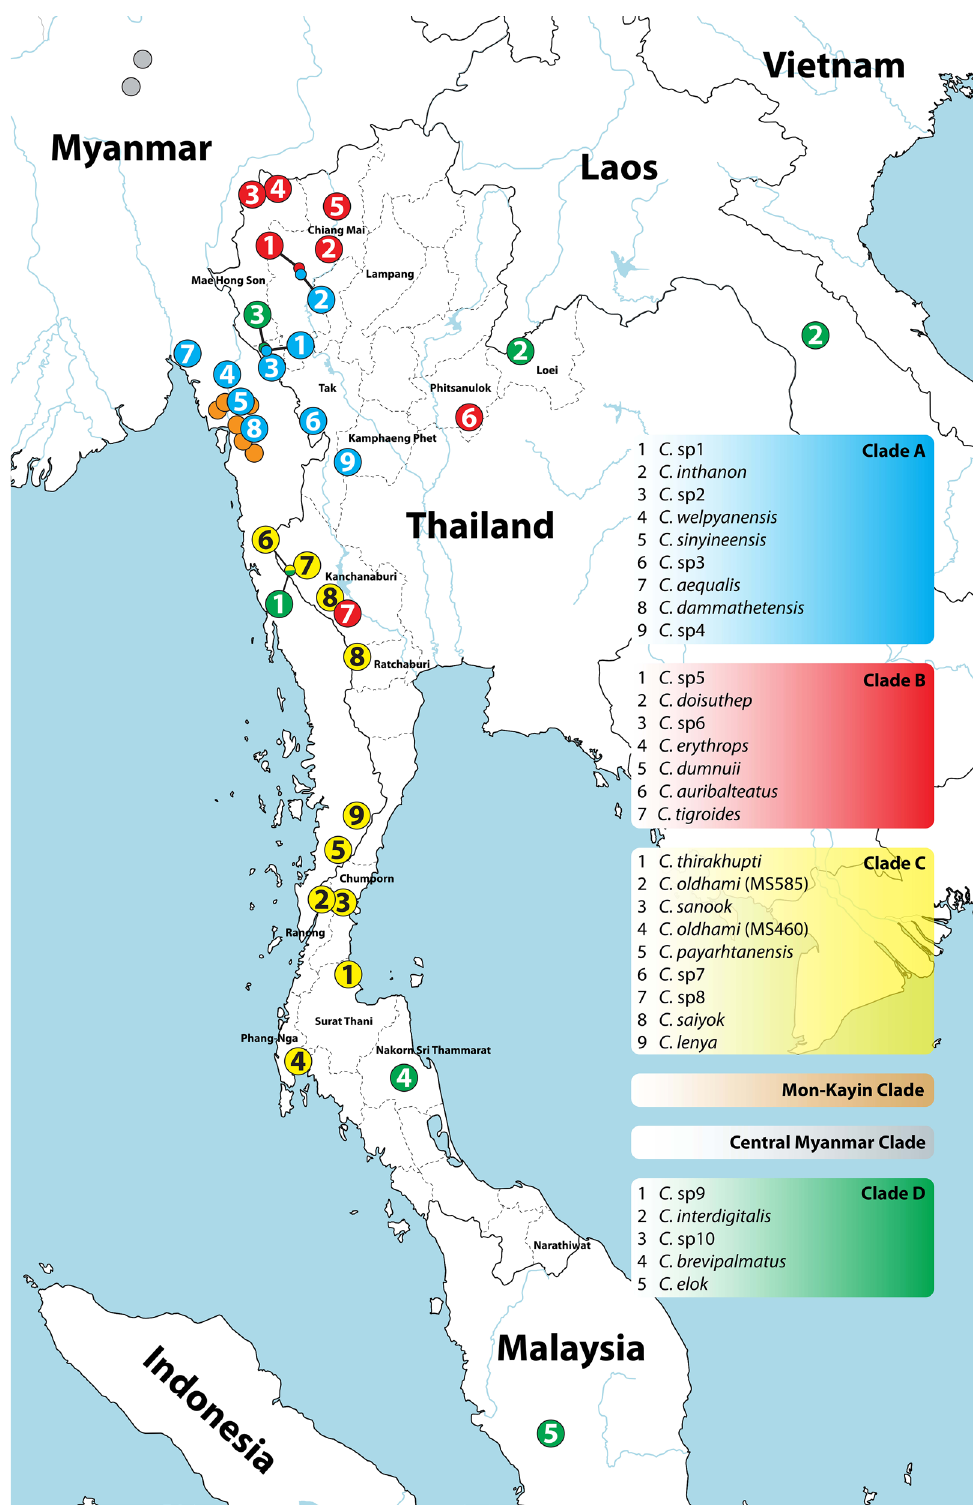
Figure 3. Distribution of Cyrtodactylus species found in northern and western Thailand. The map was downloaded from https ://www.simpl emapp